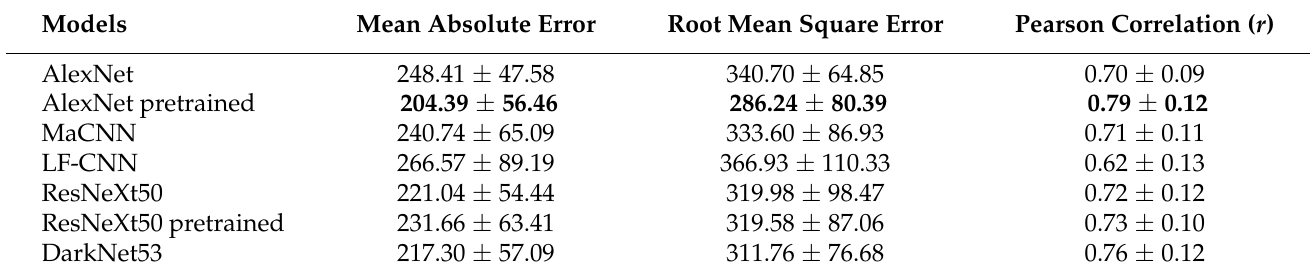
Table 3. Results for LDMY.